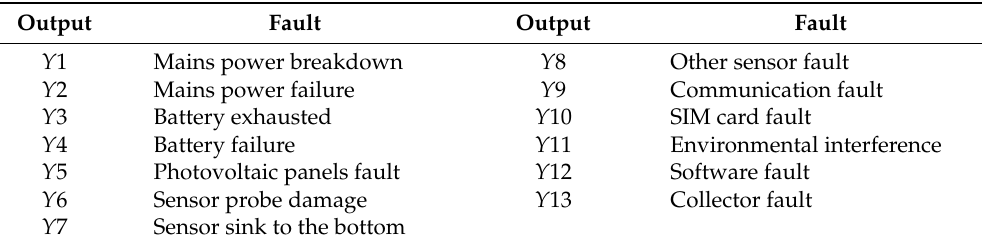
Table 4. The outputs of the fuzzy neural